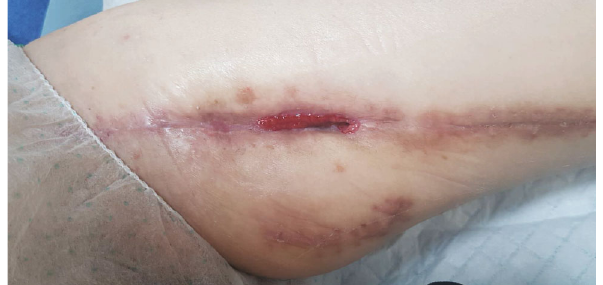
Figure 4: Postoperative wounds 10 weeks after